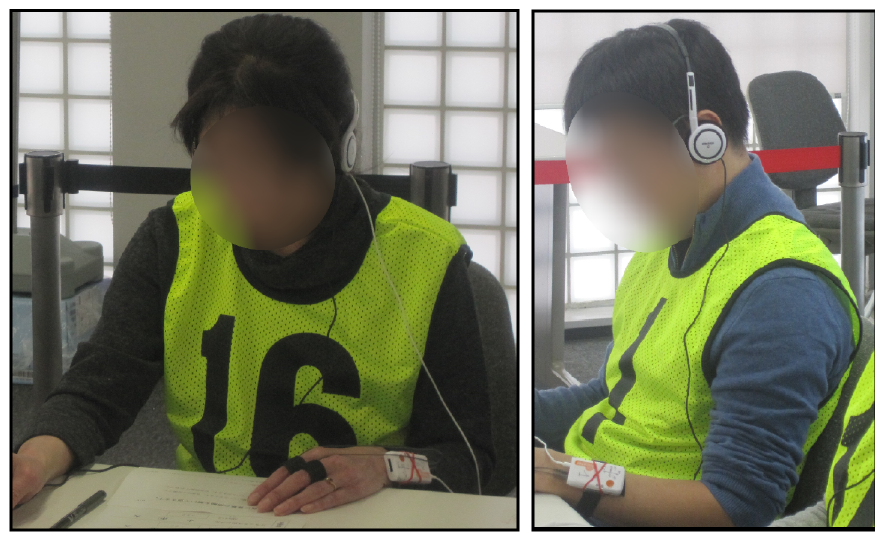
Figure 2. Example of signal acquisition in the CLAWDAS dataset: ( left ) math calculation; ( right ) re- laxing audio